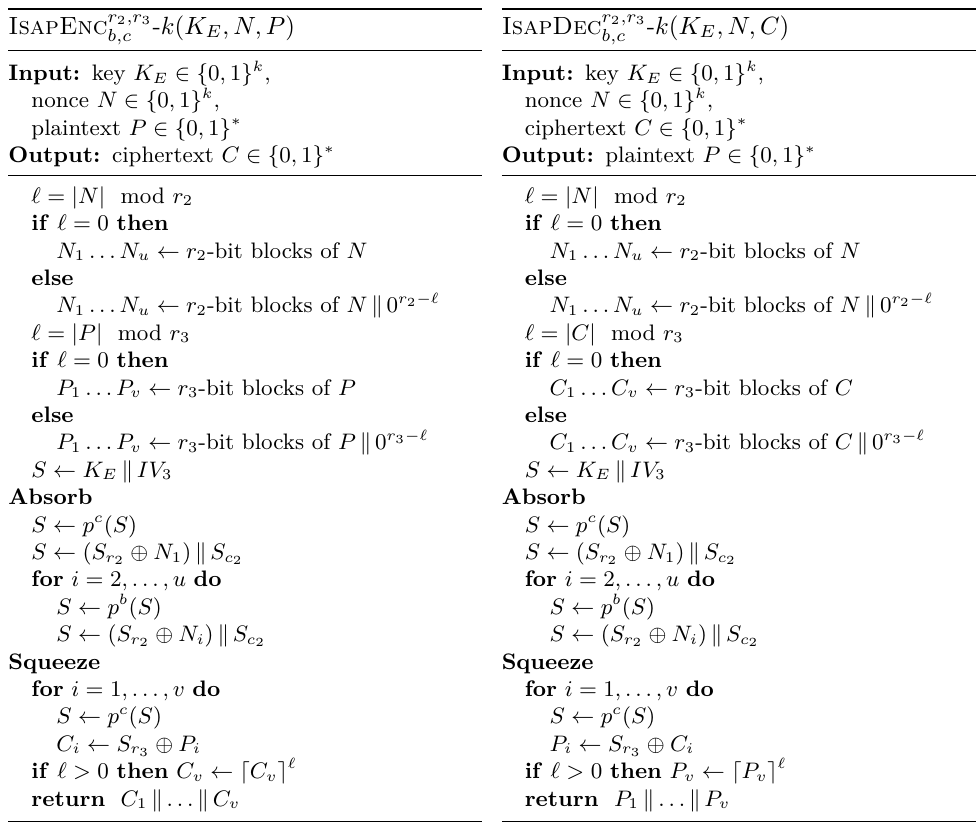
Algorithm 4: Encryption and decryption